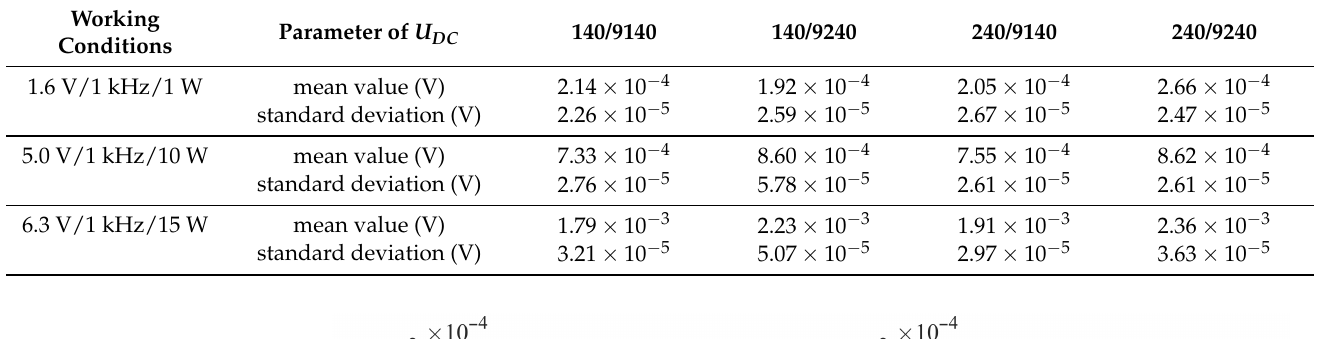
Table 4. Numerical data for Figures 12–14.